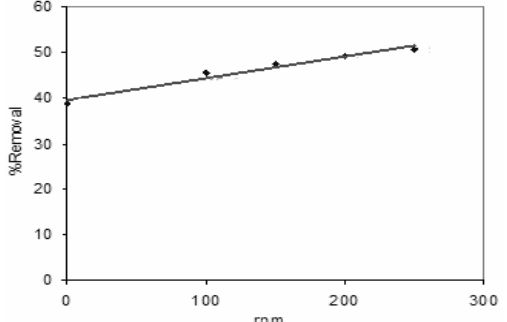
Figure 9 . Effect of agitation rate on Pb 2+ sorption PANi/SD Removal of Lead Ion from Aqueous Solutions